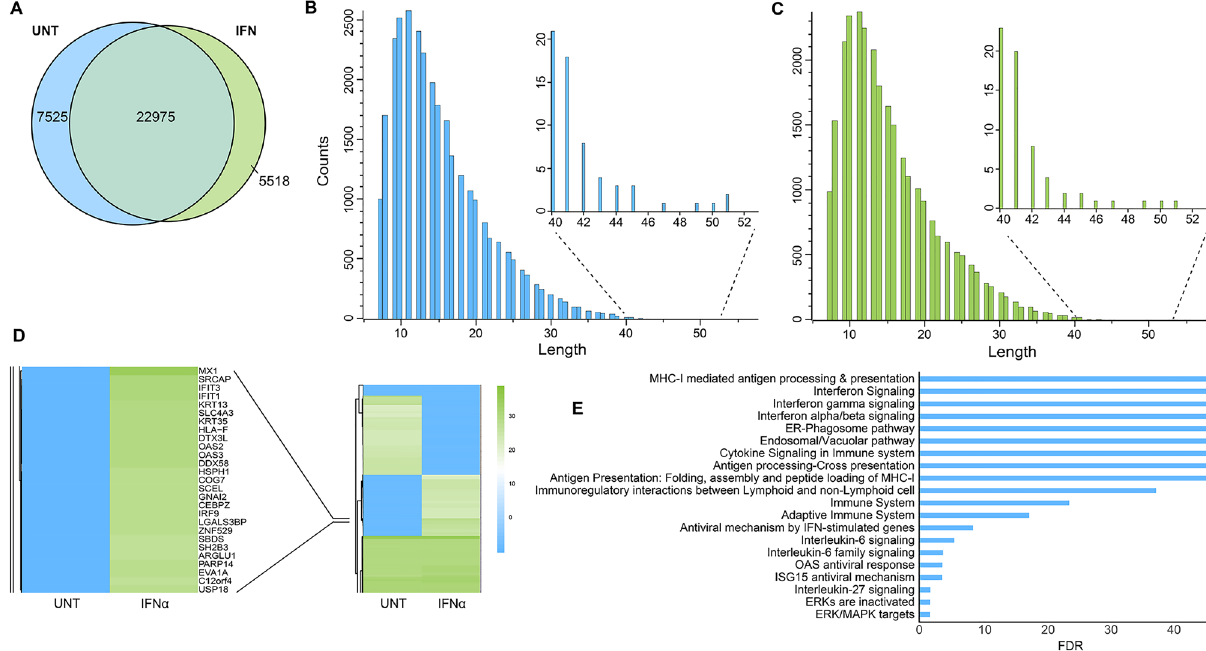
Figure 3. Identification of differentially expressed cross-linked proteins in response to IFNα (data retrieved from MaxQuant). (A) Venn diagram representing common and exclusive peptide counts identified in the IFNα14 treated and untreated Flo-1 samples. Peptide length distribution from the untreated (B) and IFNα (C) treated cross-linked samples. (D) Heatmap representing log2(LFQ intensities) between untreated and IFNα14 treated Flo-1 cells. The left panel depicts the most upregulated proteins in presence of IFNα. (E) A bar plot representing top 20 enriched pathways following IFNα treatment. IFNα responsive upregulated proteins over fourfold change were analyzed by the Reactome pathway